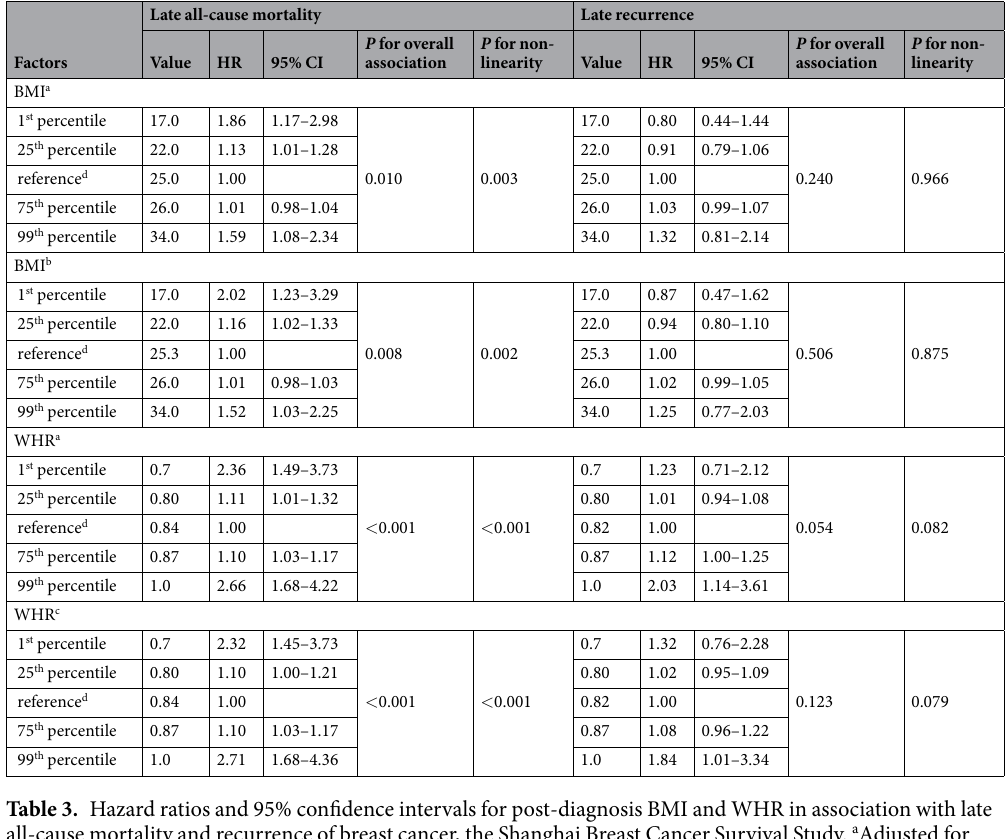
mortality. No significant modifying effect was observed for age at diagnosis ( < 65/ ≥ 65 years old), physical activ- ity (Yes/No) and comorbidity (Yes/No), either.